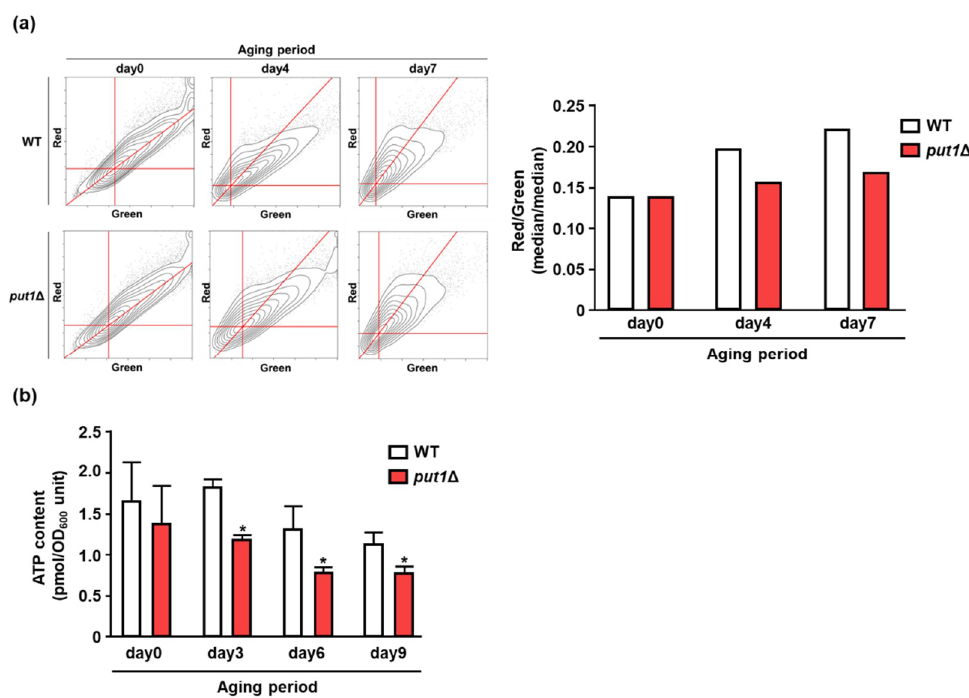
Figure 5. Put1-dependent mitochondrial energy production. ( a ) Mitochondrial membrane potential in WT and put1 Δ upon aging period. Left panel indicates representative contour-plot of JC-10 flow cytometry (event counts = 10,000). The intersection of the lines indicates the maximum population. Right panel shows median of fluorescence ratios, JC-10 aggregates (red) vs. JC-10 monomers (green). The viability of the cells used in this assay was 80–100%. Three independent experiments were performed, but representative results are presented here due to the large variation in absolute values. ( b ) ATP content in WT and put1 Δ upon aging period. ATP was detected by using the luciferase assay. Data are presented as means ± SD ( n = 10) and statistical significance was determined by Student’s t -test. * p < 0.05, vs. WT.